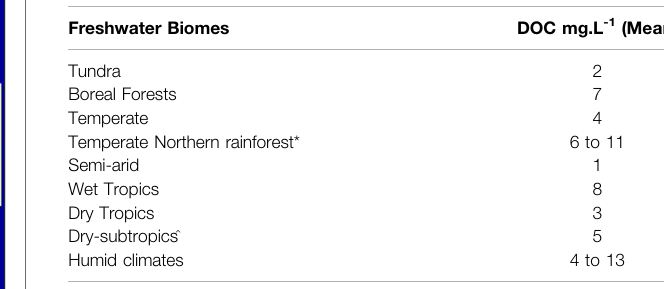
TABLE 3 | DOC concentrations in freshwater lakes and rivers in different biomes from low to high Latitudes of Northern and Southern Hemispheres (Adapted from Mulholland, (2003) additional data from ^ Pollard and Ducklow, 2011; *Oliver et al., 2017).